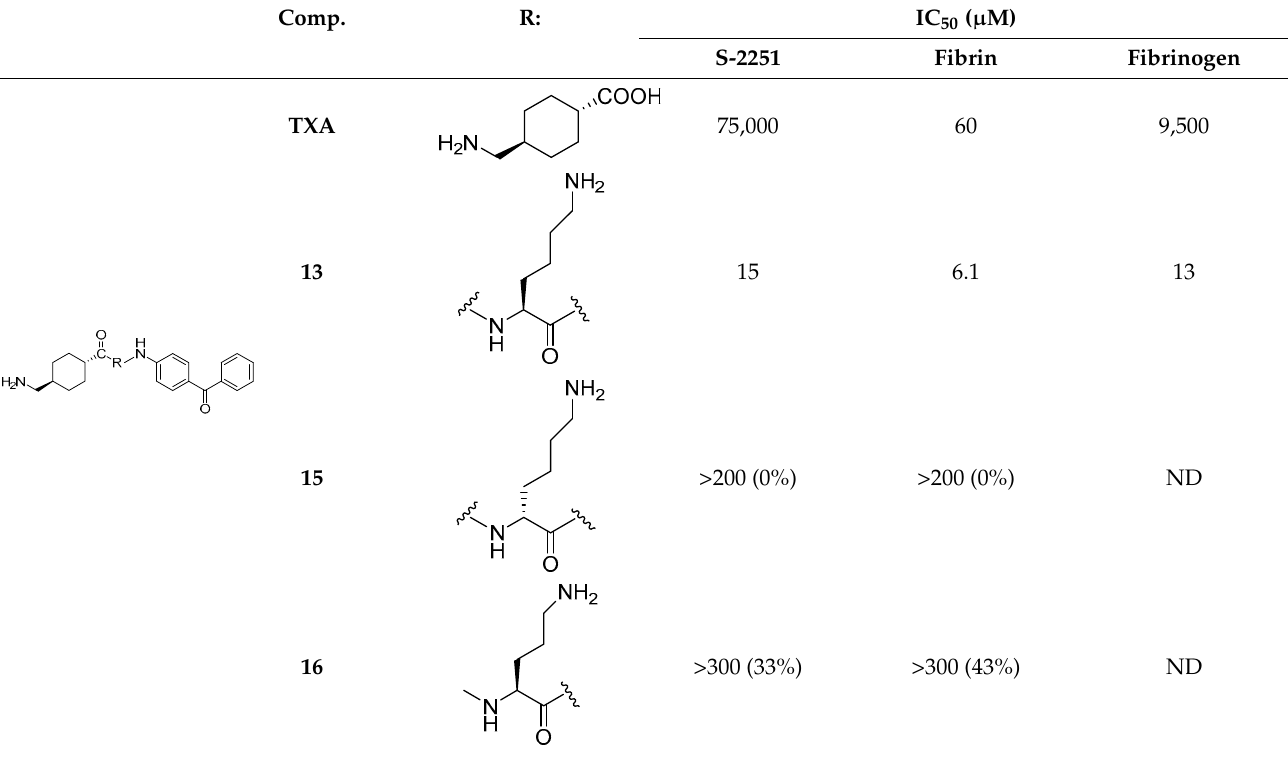
Table 4. Plm inhibitory activity of compounds 13 [29] , 15 [29], and 16 [29]. Comp.